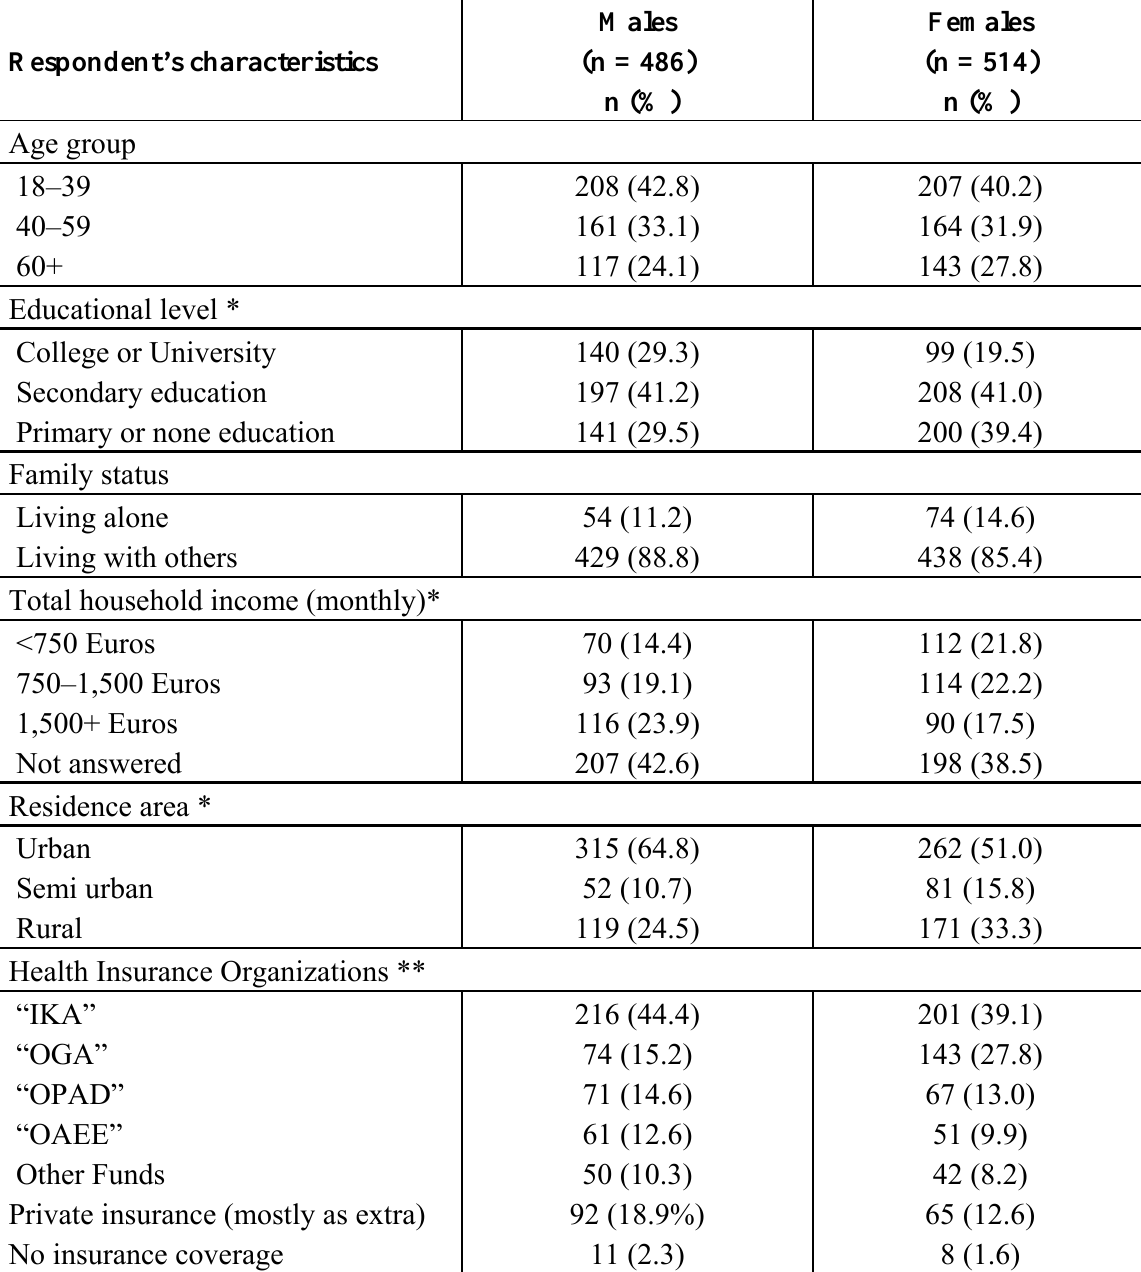
Table 1. Individual characteristics of respondents (n =